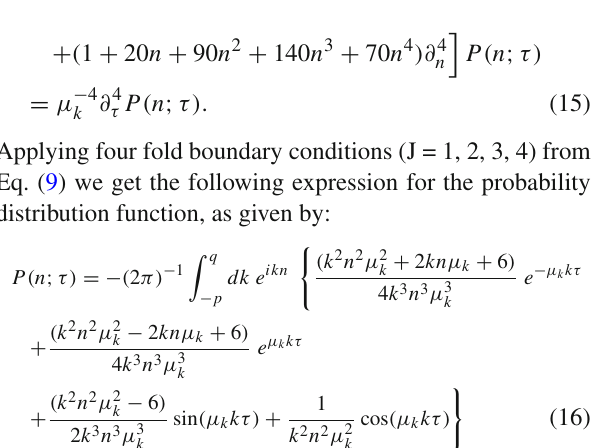
Fig. 2 Time evolution of variance, skewness and kurtosis computed from the probability distribution